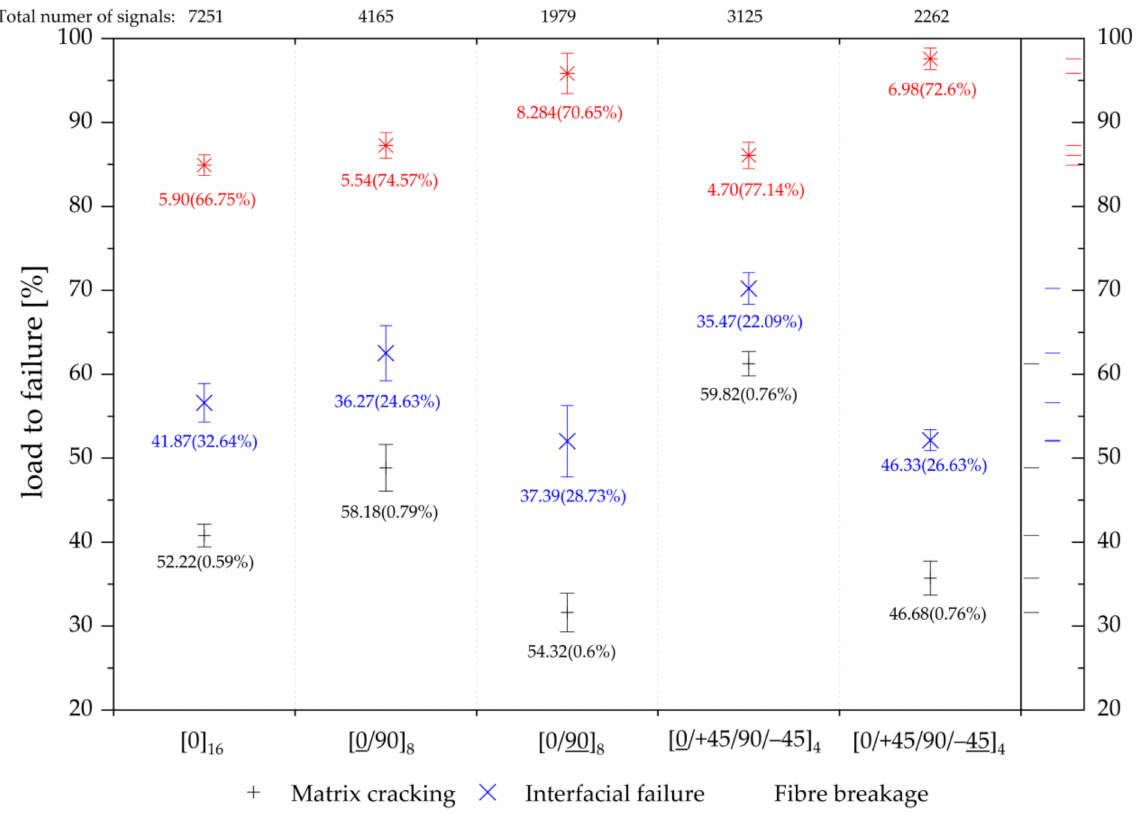
Figure 7. The load-to-failure values of the onset of each damage